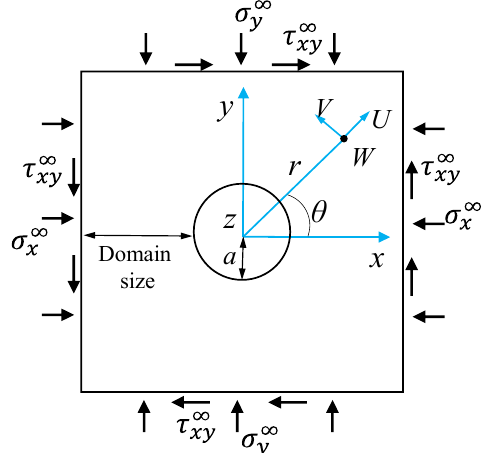
Figure A1. Physical plane strain model of a cylinder hole in an infinite linearly elastic material. When the infinite hole is subject to a stress field composed of (cid:2026) (cid:3051)(cid:2998) , (cid:2026) (cid:3052)(cid:2998) , (cid:2026) (cid:3053)(cid:2998) , (cid:2028) (cid:3051)(cid:3052)(cid:2998) , (cid:2028) (cid:3051)(cid:3053)(cid:2998) ,